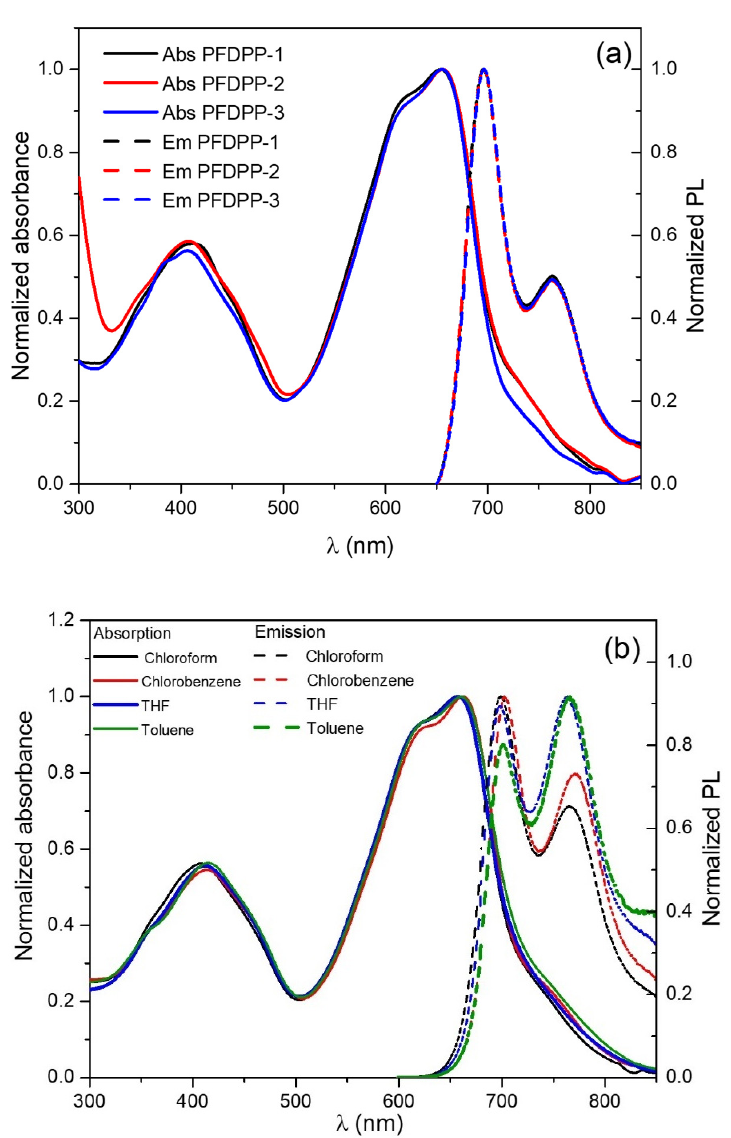
Figure 5. Normalized absorption and emission spectra of PFDPP polymers ( a ) in chloroform and ( b ) in different solvents. ( λ ex = 600 nm). Table 4. Optical parameters of PFDPP polymers.